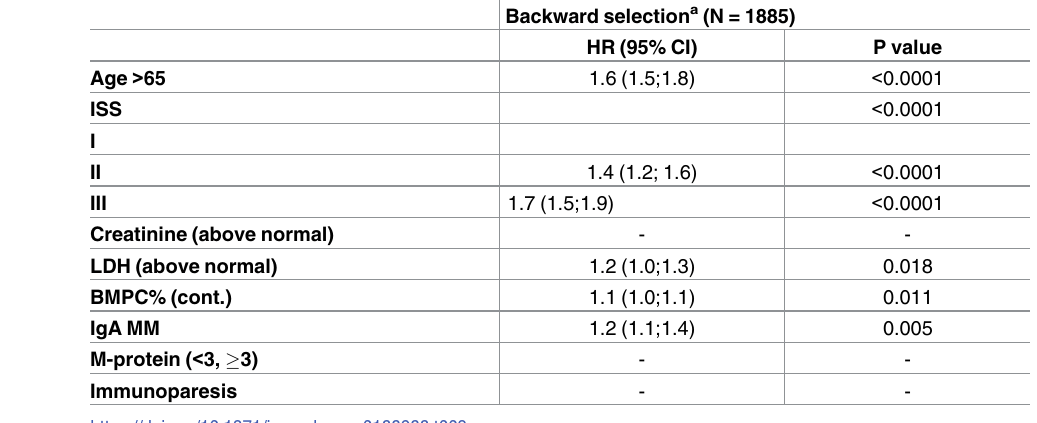
Table 3. Multivariable analysis of factors for